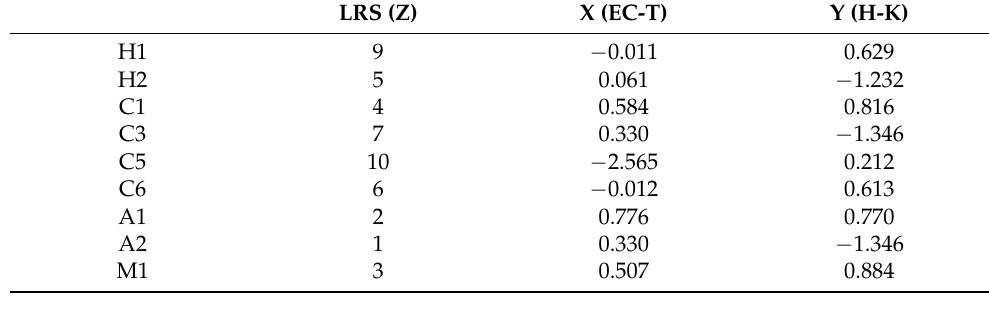
groundwater habitats and factors ( X) and abiotic environmental conditions ( Y ) monitored between